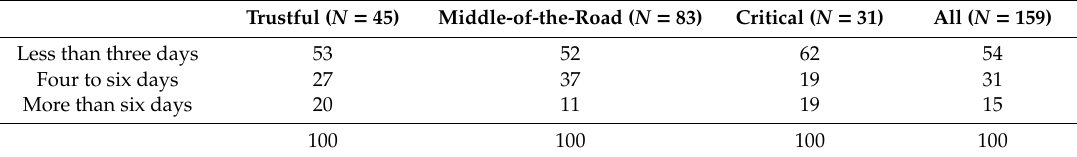
Table 6. Responses to question: On average, how many days do you use for your municipal elected positions per month